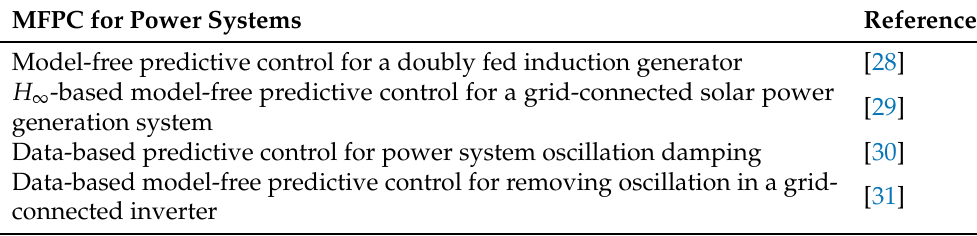
Table 4. Research papers on application of model-free predictive control in power